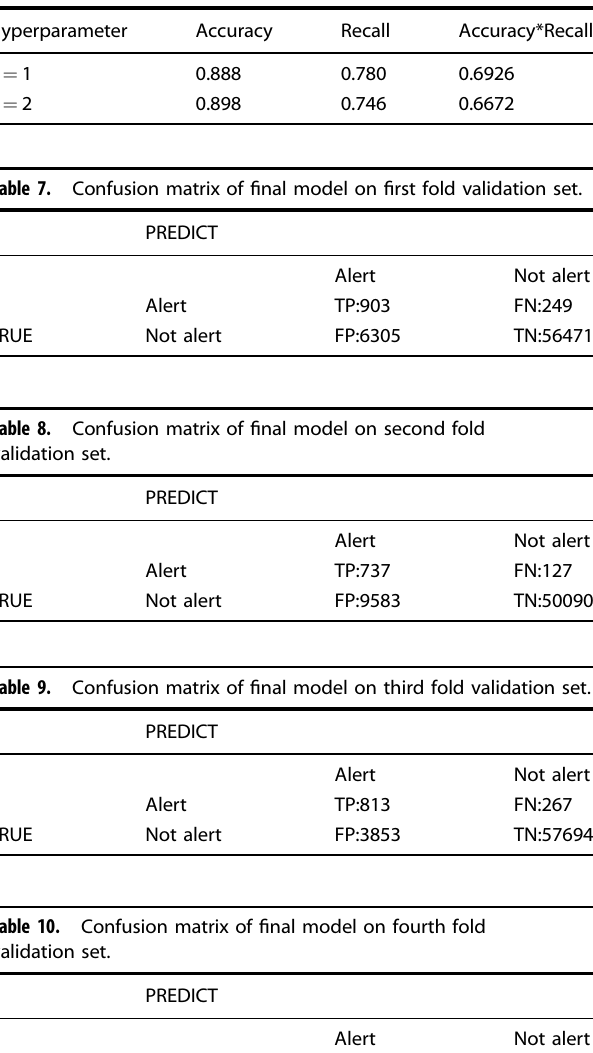
Table 6. Validation results for loss function constants.